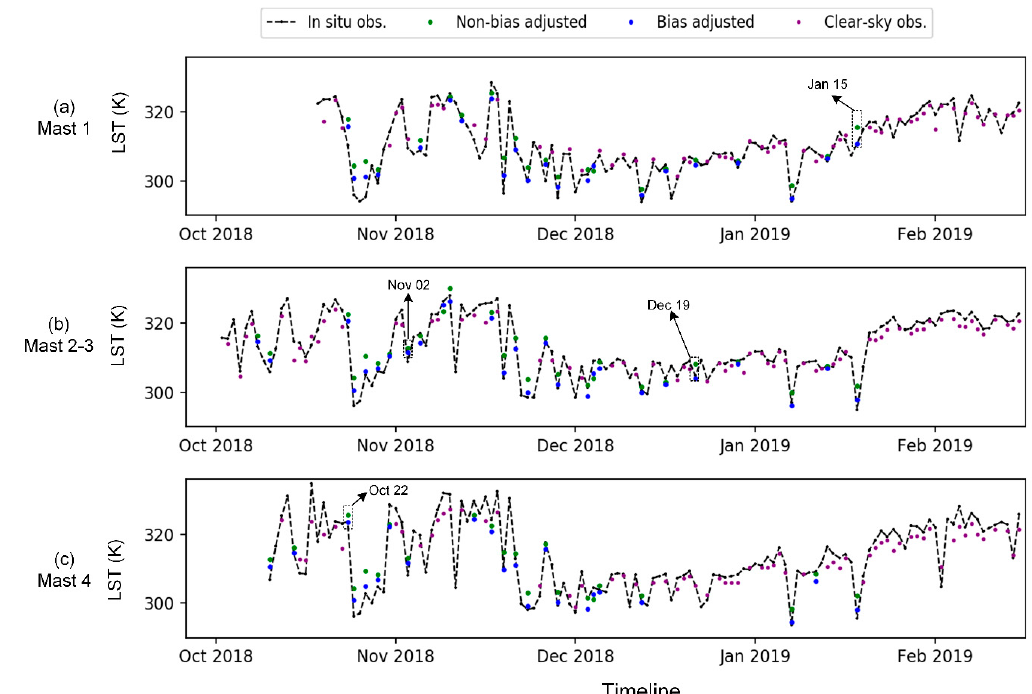
Figure 5. Comparison of MODIS Clear (green ‘x’), MODIS STDF (orange plus sign) and MODIS PMBC (blue dot) data to corre- sponding in situ LSTs recorded using the mast-mounted IR radiometers of the ILRI Kapiti Research Station detailed in Figure 1. Day-time data are collected around 1:30 p.m. local solar time, whereas night-time data are around 1:30 a.m. The 1:1 line is also shown, and comparison statistics are presented in Table 3. The clearest benefit of the bias-adjusted gap filling is seen in the coolest temperatures of the day-time record.